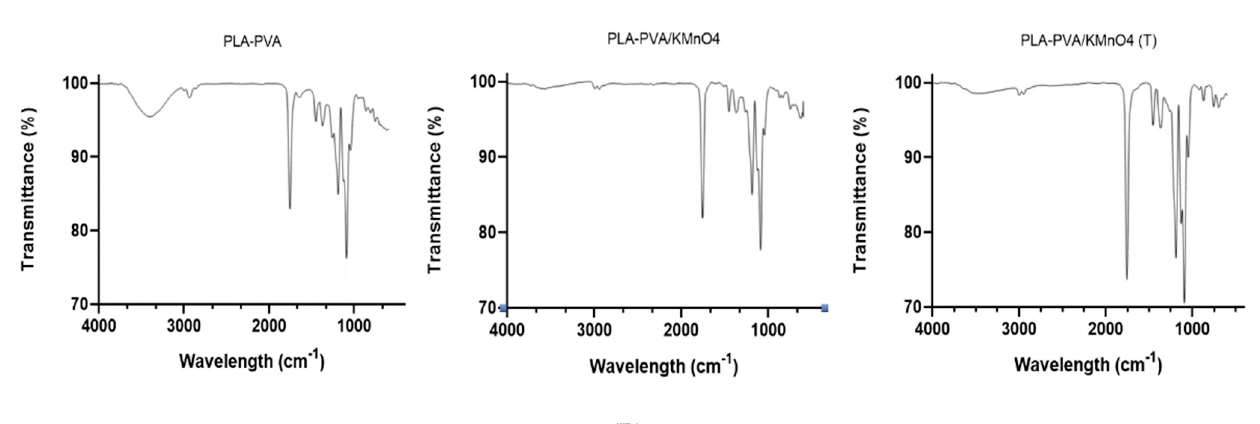
Figure 2. ( A ). FT-IR spectra of PLA-PVA (a), PLA-PVA (T) (b), PLA-PVA/KMnO 4 (c), PLA-PVA/KMnO 4 (T) (d), PLA- PV/NaCl (e), PLA-PVA/NaCl (T) (f) bioscaffolds. ( B ). FT-IR spectra of PLA-PVA, PLA-PVA/KMnO 4 , and PLA-PVA/KMnO 4 (T) of bioscaffolds. Table 1. Selected material-related properties of the bioscaffolds before and after thermal treatment. Untreated After Thermal Treatment